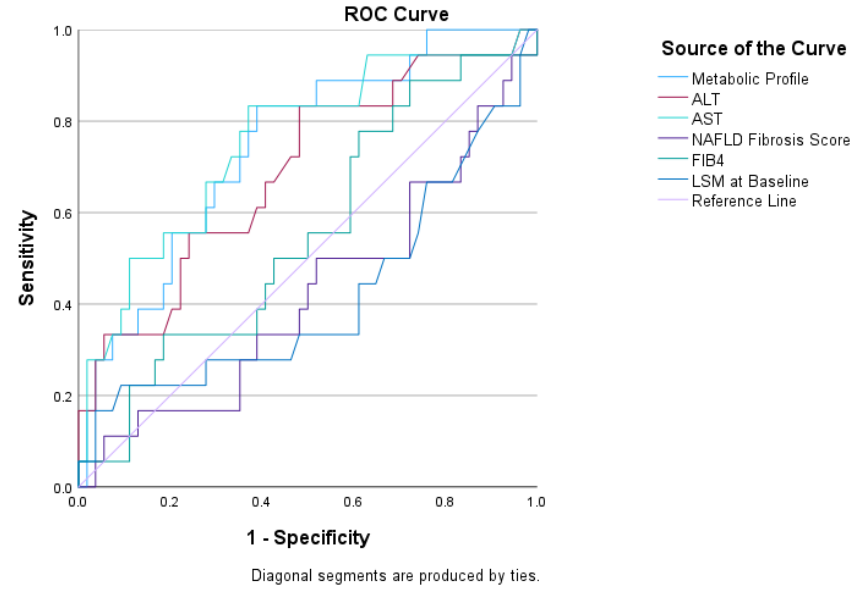
Figure 2. Diagnostic performance of metabolic profile for predicting fibrosis progression compared to ALT, AST, NAFLD fibrosis score, FIB-4 and LSM in patient who had had a liver biopsy. Abbreviations: ALT, alanine aminotransferase; AST, aspartate aminotransferase; LSM: liver stiffness measurement. 2.4. Metabolic Profile in Cirrhotic vs. Noncirrhotic Patients